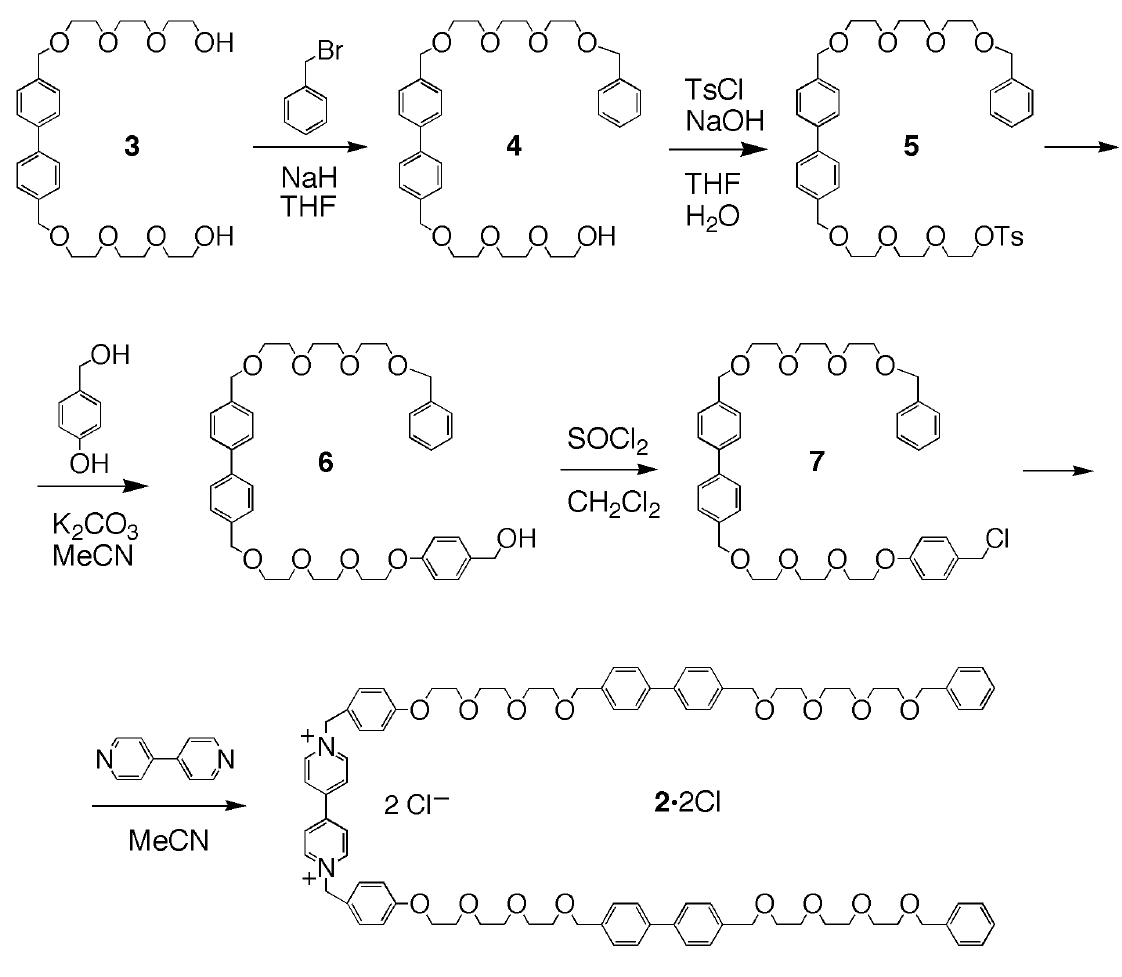
Scheme 1 . Synthesis of the linear component 2 ⋅ 2Cl.